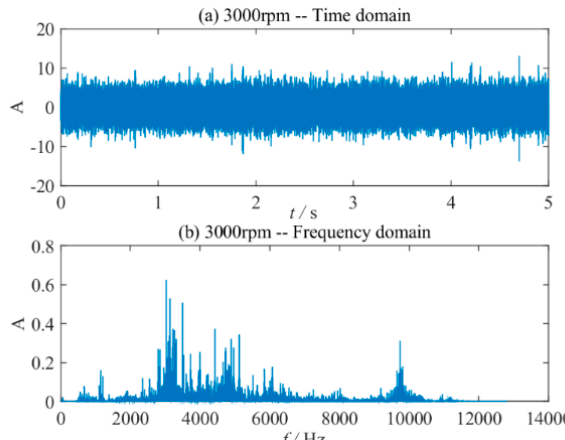
Figure 2. Damage elements of bearings. ( a ) The scratched inner ring. ( b ) The scratched ball.